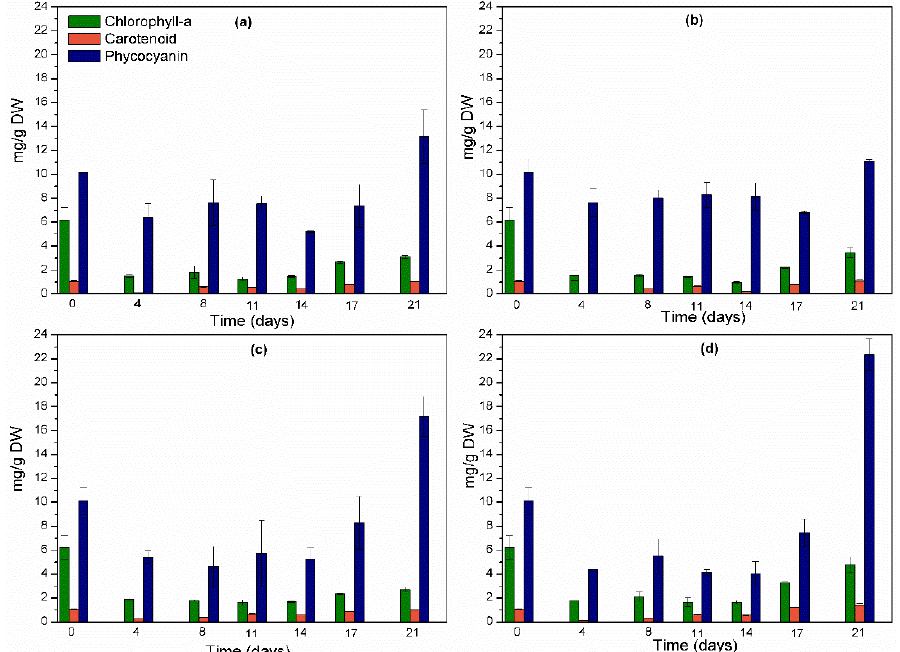
Figure 2. Pigments content into total biomass during A. platensis cultivation under continuous illumination in ( a ) untreated brewery wastewater, ( b ) brewery wastewater with 1 g/L NaCl, ( c ) brewery wastewater with 5 g/L NaHCO 3 , and ( d ) brewery wastewater with 1 g/L NaCl and 5 g/L NaHCO 3 . Data present mean values of duplicate experiments ± standard deviations.